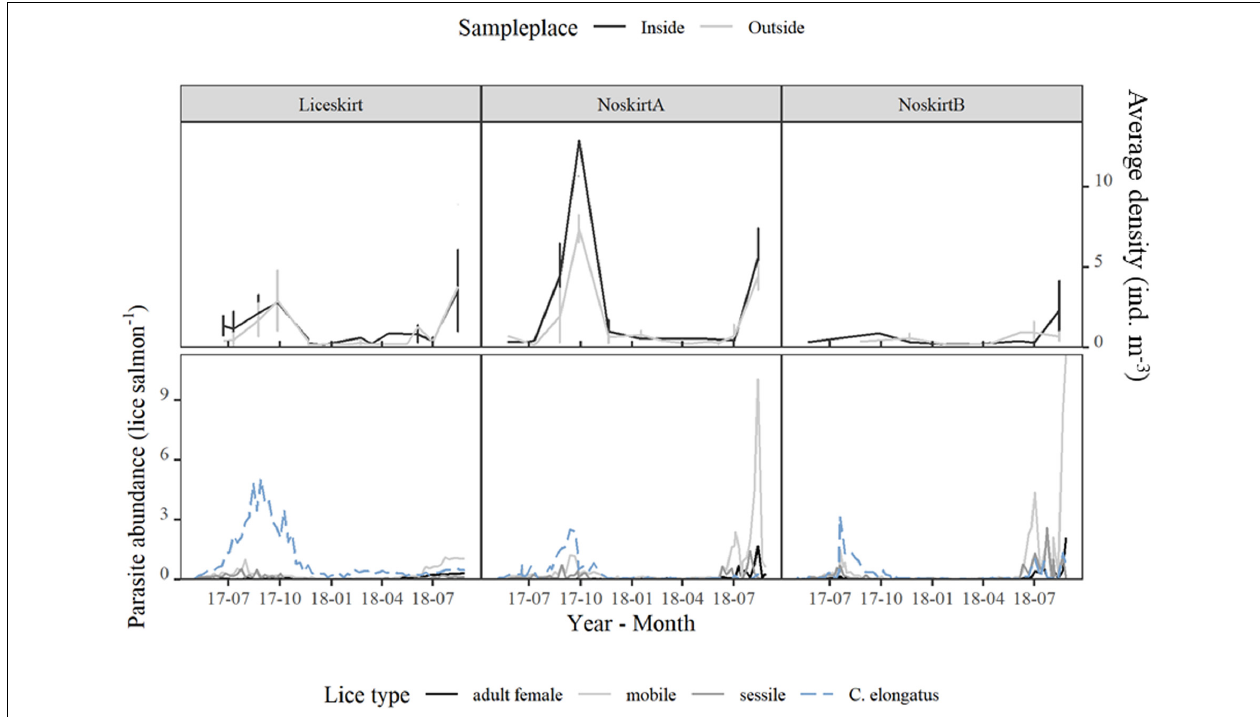
FIGURE 5 | Distribution of parasite stages of sea lice in the sampling period. Upper panel: average density (individuals m − 3 , samples containing lice) of planktonic sea lice. Error bars show ± SD. Lower panel: parasite abundance (number of lice per salmon) for the three localities.